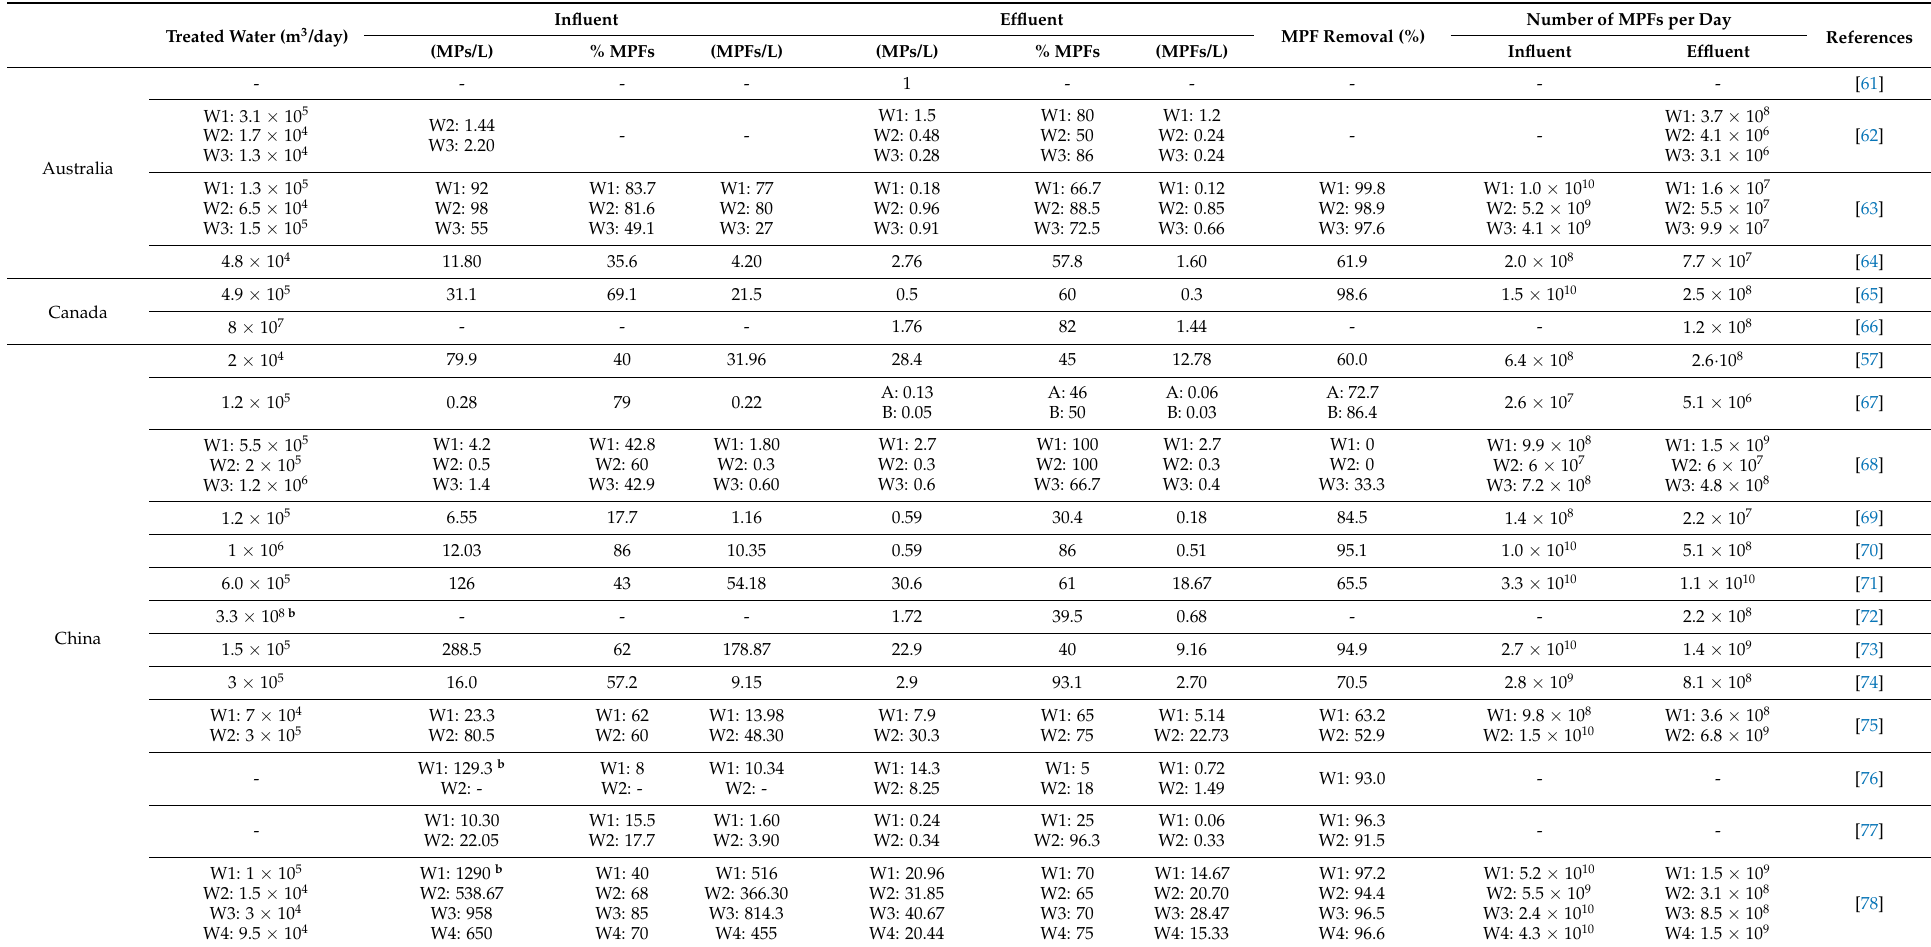
Table 1. Overview of the incidence of MPs, and specifically microfibres, in the influent and the effluent of different WWTPs worldwide. “W” followed by a number refers to different WWTP analysed in the cited reference.